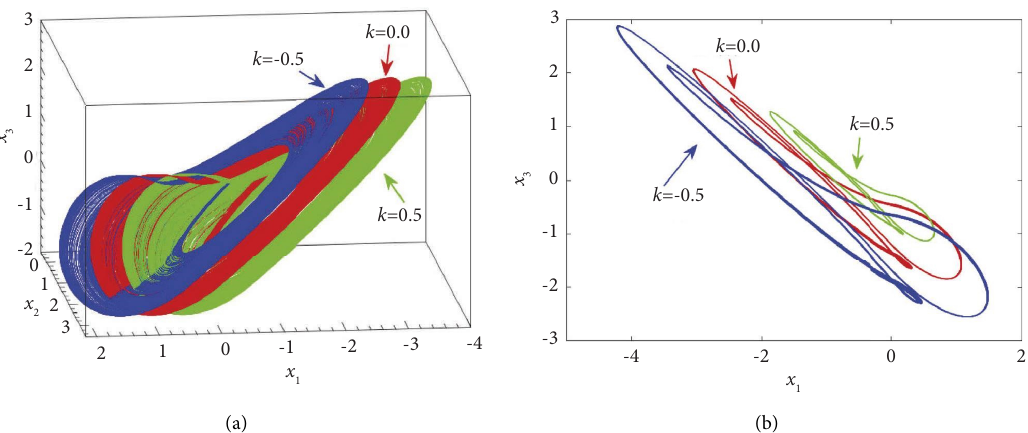
Figure 16: System phase diagrams with single control parameter k variation. (a) Chaotic phase diagrams of system (9) on space x (b) periodic phase diagrams of system (9) on plane x